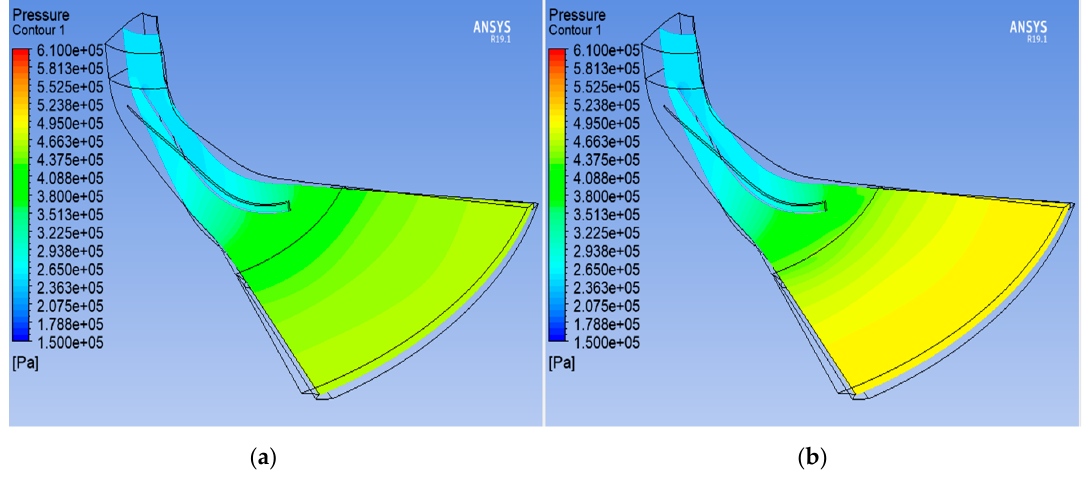
Figure 7. Pressure Contour for R152a at an RPM of 35,000 ( a ) and 40,000 ( b